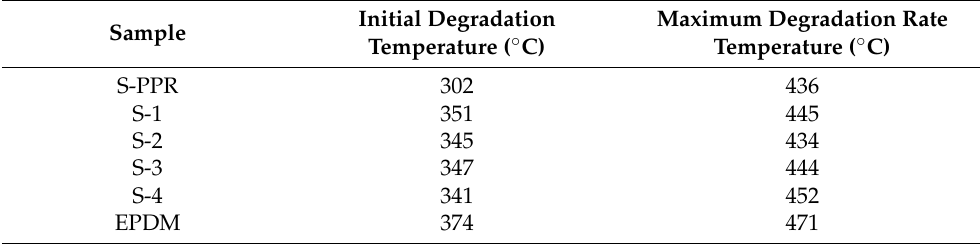
Figure 6. ( a ) Curves of thermal degradation of various materials; ( b ) curves of derivative weight of various materials. Table 3. Summary of various degradation Table 4. Summary of thermal properties of various materials via DSC.